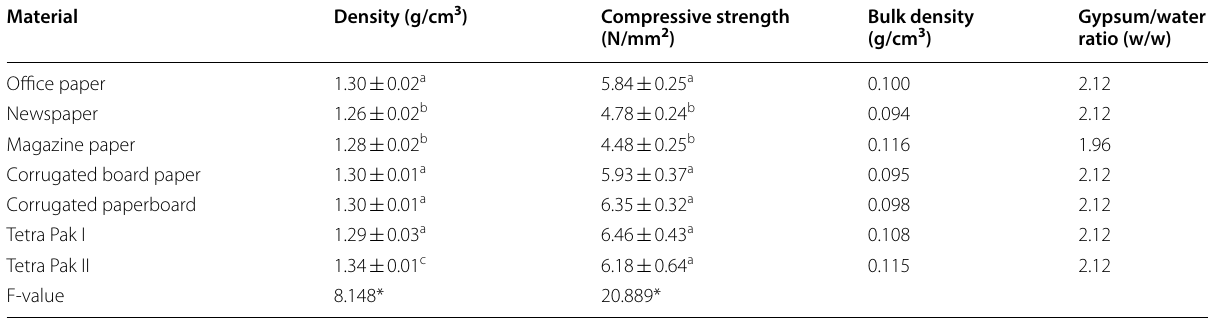
Mean values and standard deviations ( ) of five replicates ± * Mean values in the same column followed by different superscript letters (“a,” “b,” “c”) are significantly different (ANOVA and two-sample t test, p < 0.05)